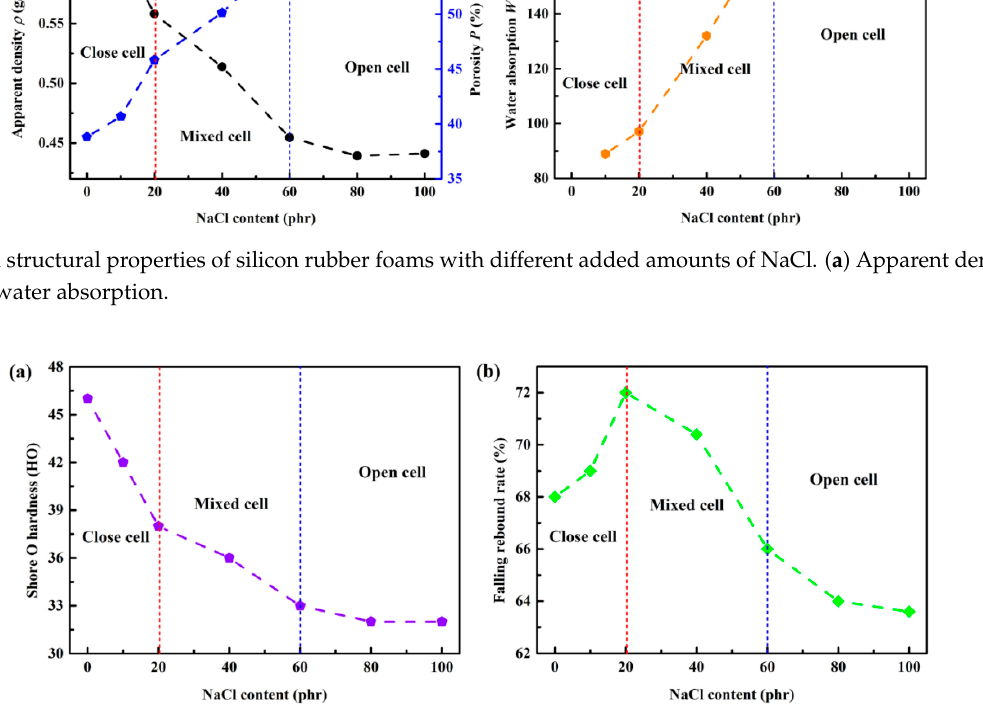
Figure 3. Elastic properties of silicon rubber foams with different added amount of NaCl. ( a ) Shore O hardness; ( b ) falling rebound rate.